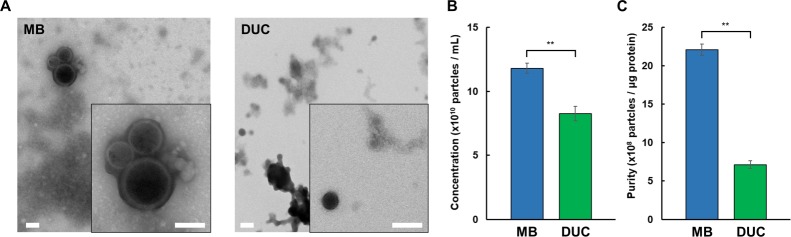
Nanoparticle and protein analysis of MB eluates and DUC concentrates.Transmission electron micrographs of negatively stained EVs isolated and eluted from magnetic beads (MB) or pelleted by differential ultracentrifugation (DUC) methods from PPP. Scale bars represent 100 nm. The double-layer character of EV membranes could be discerned at increased magnification (insets) (A). Enumeration of nanoparticles in MB eluate and DUC concentrate by NTA (B). Protein levels were quantified using MicroBCA assays. The ratio of nanoparticle concentration to μg protein was plotted as a relative measure of purity (C). Data are expressed as mean ± SEM from three measurements (** p < 0.01, Student’s t-test).